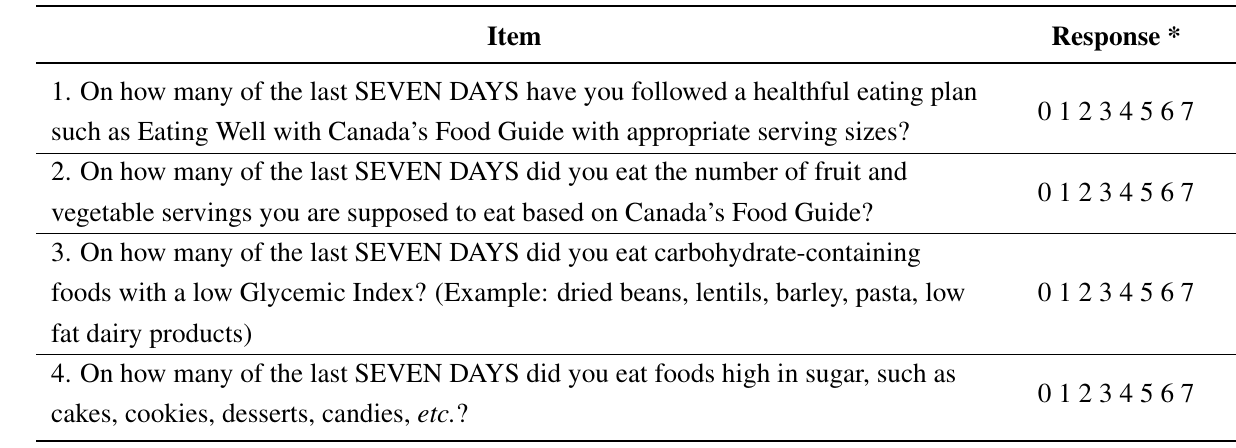
Table 1. Perceived Dietary Adherence Questionnaire